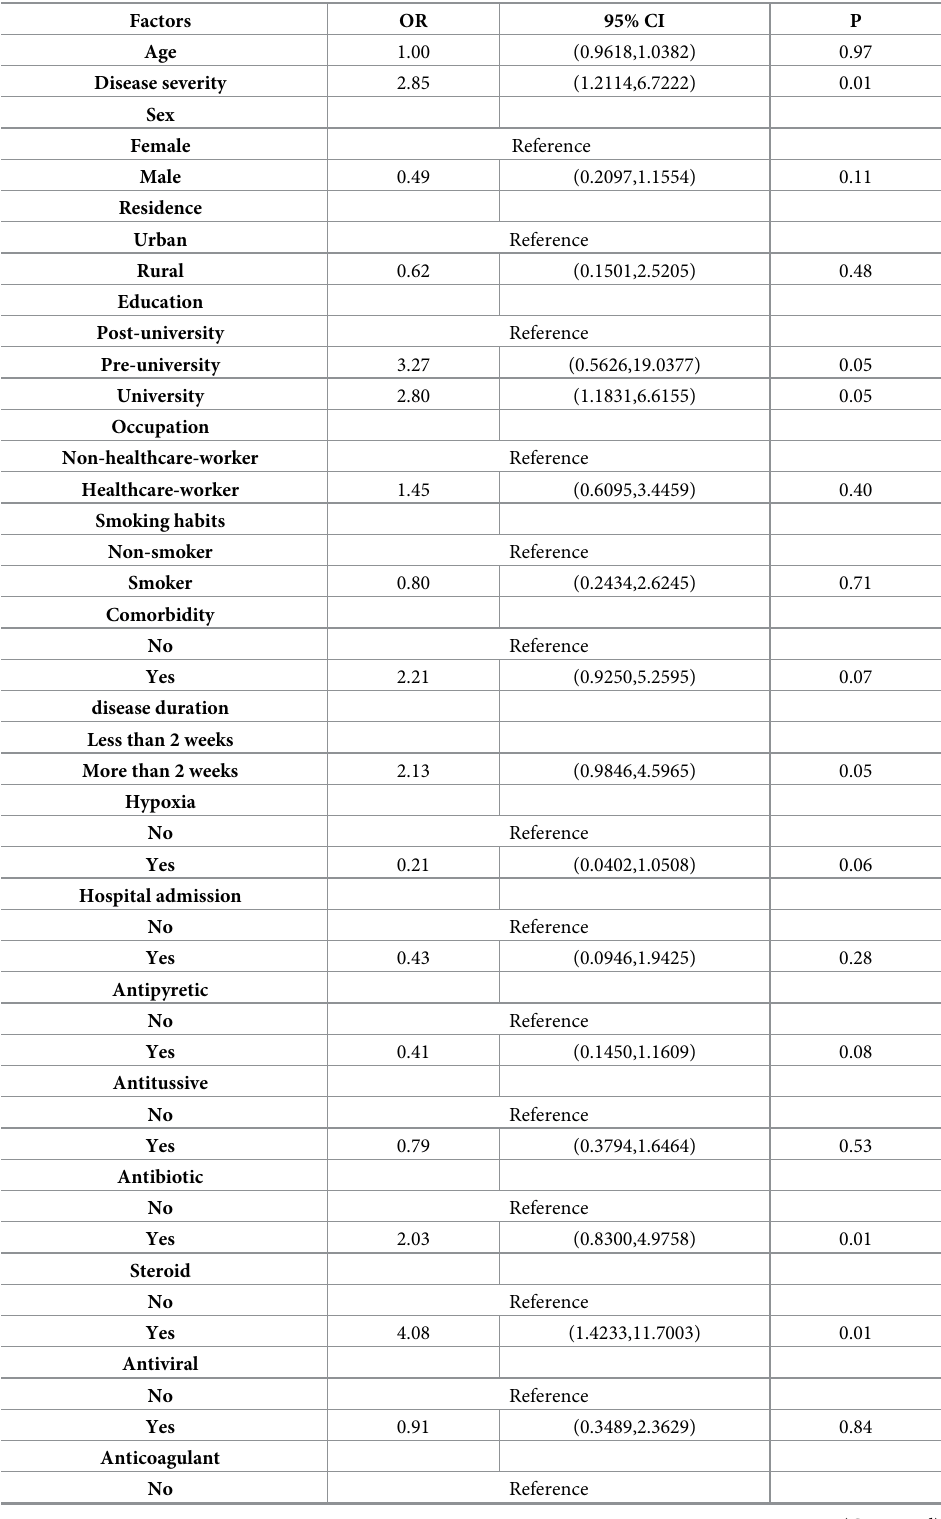
Table 4. Predictors of post COVID